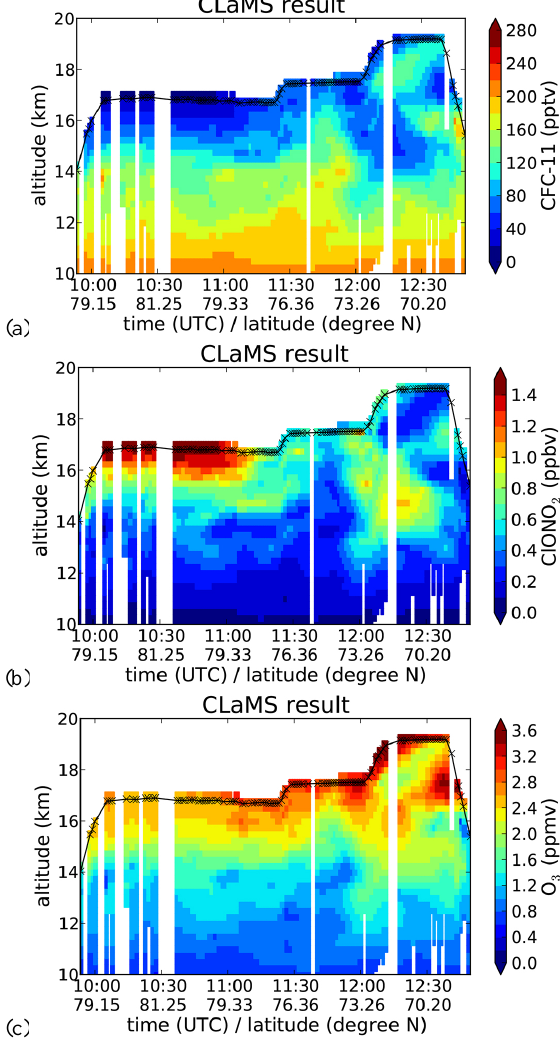
Fig. 5. CLaMS results for CFC-11, ClONO 2 , and O 3 for RECON- CILE flight 11 (2 March 2010). For details see caption of Fig.